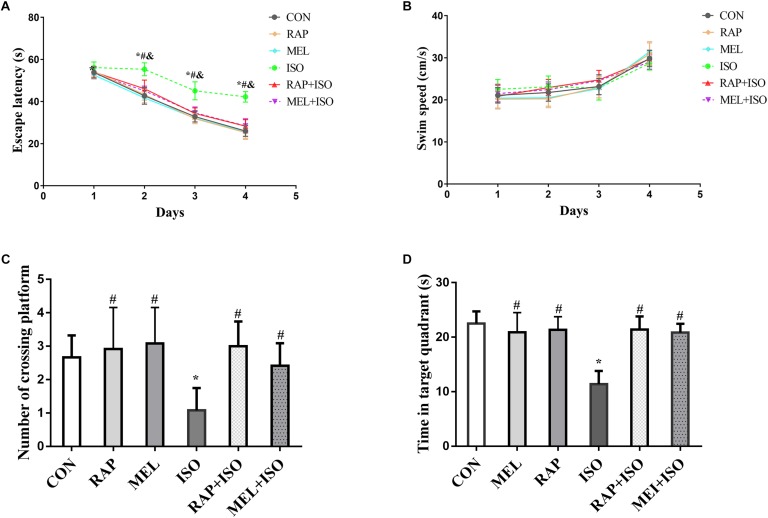
Rapamycin and melatonin suppresses isoflurane-induced decline in cognitive impairment. (A) Isoflurane resulted in prolonged escape latency in the Morris water maze (MWM) test. Rapamycin and melatonin both reduced the increased duration of isoflurane-induced prolongation of escape latency. Data are depicted in terms of mean ± SD (n = 12). ∗P < 0.05 ISO group versus CON group; #P < 0.05 RAP + ISO group versus ISO group; &P < 0.05 MEL + ISO group versus ISO group. (B) Isoflurane had no effect on mice swimming speed. (C,D) Isoflurane lowered the number of platform location crosses and the target quadrant dwell time, and melatonin suppressed the isoflurane-induced lowering in number of platform location crosses and target quadrant dwell time. There was no difference among the CON, RAP, RAP + ISO, and MEL + ISO groups in the result of the MWM. Data are depicted as the mean ± standard error (n = 12). ∗P < 0.05 versus CON group; #P < 0.05 versus ISO group.